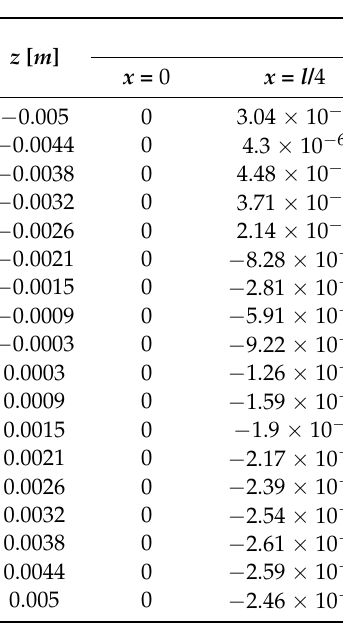
Figure 5. Longitudinal distribution of the axial ( a ) and radial ( b ) displacement components [m], for different volume fractions. Table 3. Variation of the longitudinal displacement field along the radial direction at different longitudinal